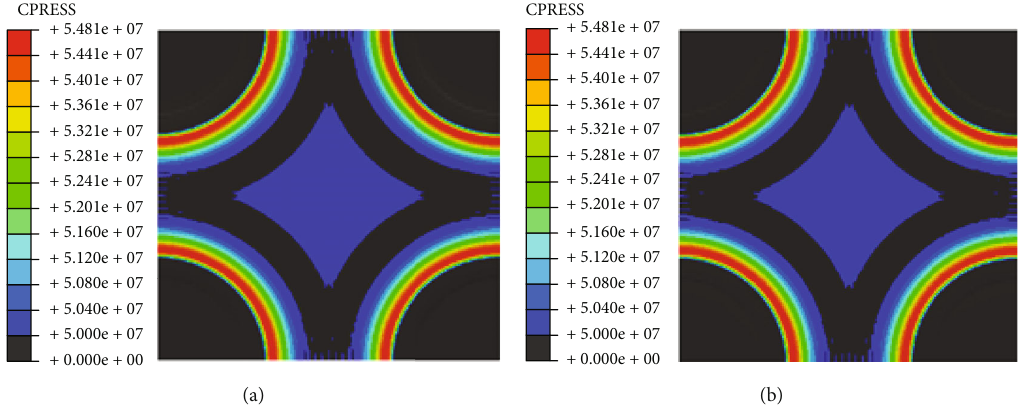
Figure 13: Contact stress cloud images of upper slab (a) and lower slab (b).